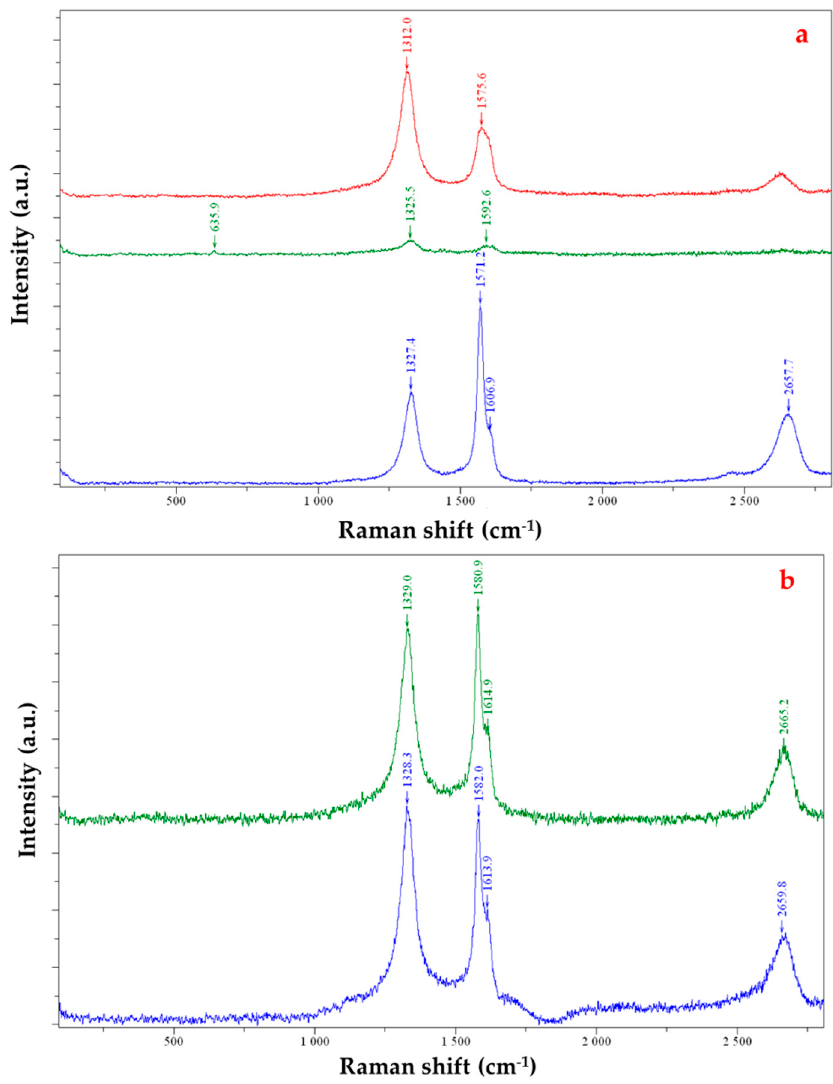
Figure 7. Raman spectra of solid-state films of ( a ) CNHox/GO/SnO 2 /PVP = 0.75/0.75/1/1 (mass ratio) deposited on a silicon substrate (three different measuring points of the film deposited from the quaternary nanocomposite-red, green, and blue curves), and ( b ) CNHox/GO/SnO 2 /PVP = 1/1/1/1 (mass ratio) deposited on a silicon substrate (two different measuring points—green and blue curves).